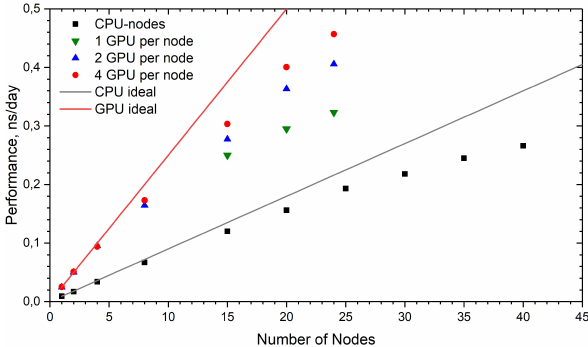
Figure 8: Parallel advection-driven aggregation solver on CPUs, Ballistic kernel, domain size N = 12288 . Table 6: Computational times for 10 time-integration steps for par- allel implementation of the algorithm for ternary aggregation equa- tions with N = 2 19 nonlinear ODEs.